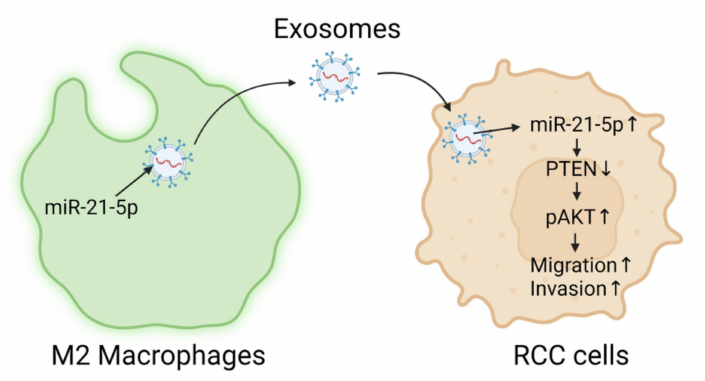
Figure 7. Schematic diagram of the proposed mechanism of M2-Exos mediated enhancement of RCC aggression via